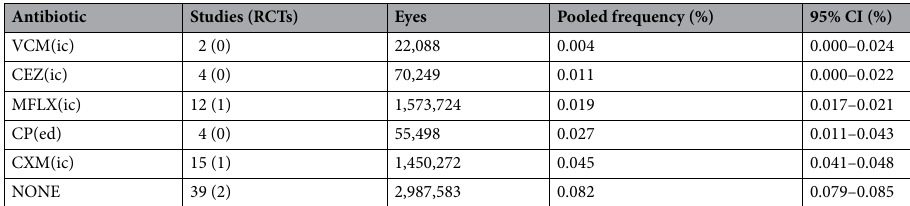
Antibiotic Studies